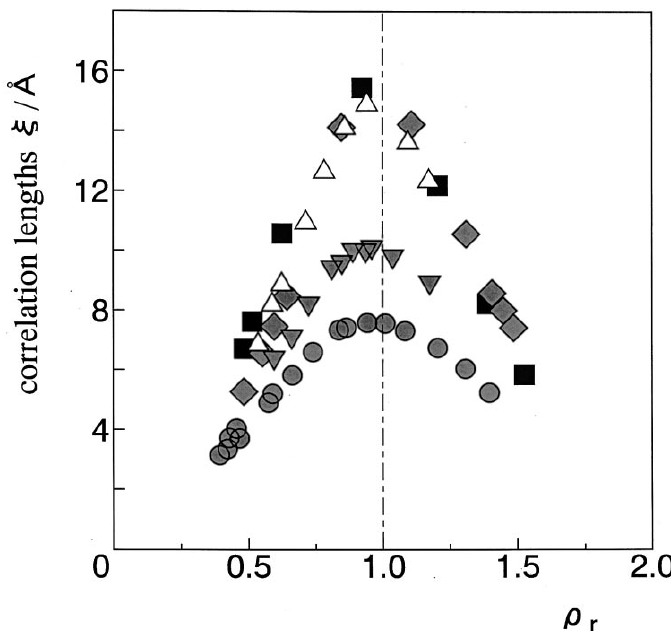
Figure 3. The isothermal changes of correlation lengths for SCW as a function of density. The symbols of shaded square ( ■ ), shaded diamond ( ◆ ), open triangle ( Δ ), shaded inverted triangle ( ▼ ), and shaded circle ( ● ) represent isotherms at temperatures T = 660.0, 661.5, 663.0 K ( T r = 1.02), 677.0 K ( T r = 1.05), and 687.5 K ( T r = 1.06), respectively. The chain line denotes the critical density. This figure is reprinted from JCP , 2000 , 112 , 4203.